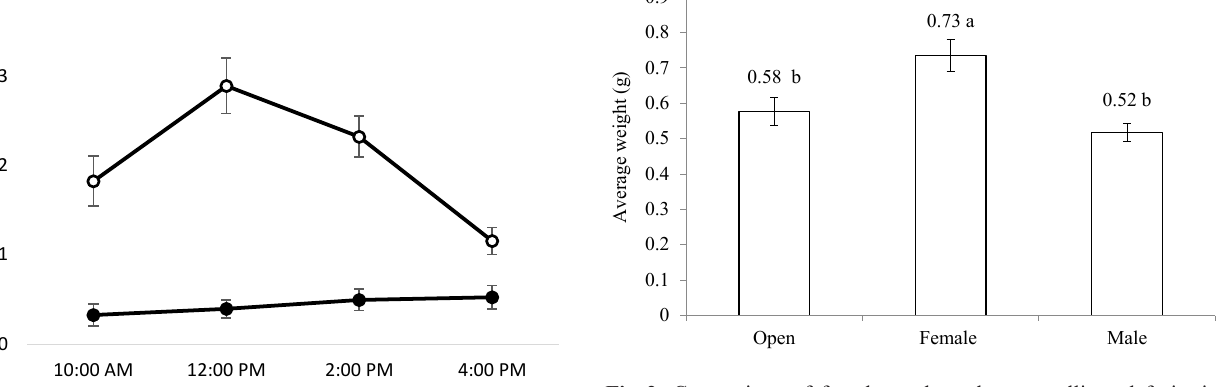
Fig 2 . Comparison of female, male and open pollinated fruits in terms of their weight. Means sharing similar letters are statistically non-significant at alpha